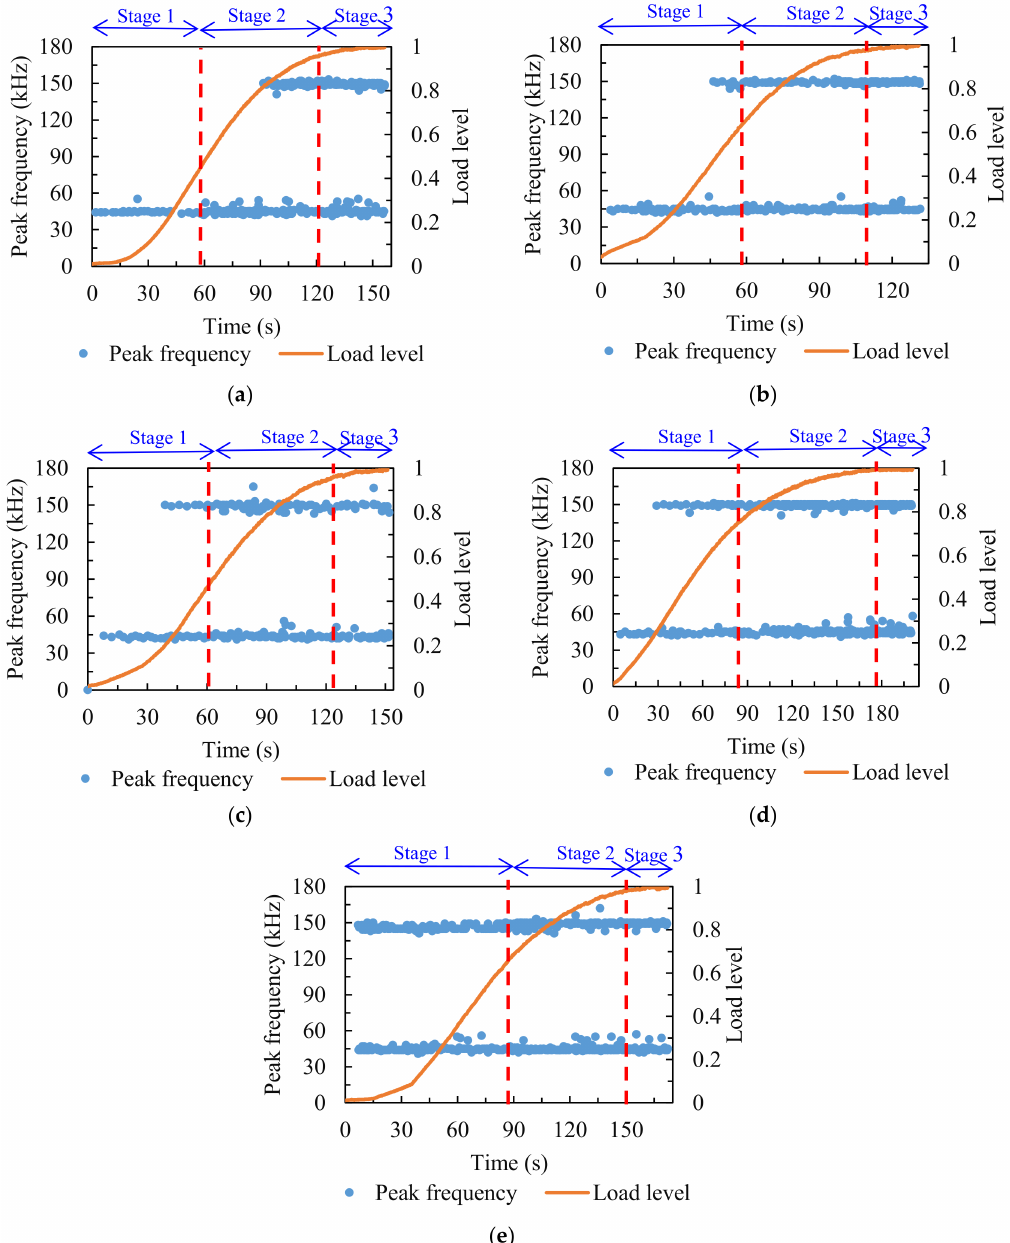
Figure 7. Peak frequency distribution of specimens treated with various F–T cycles: ( a ) 0; ( b ) 1; ( c ) 3; ( d ) 5; ( e )